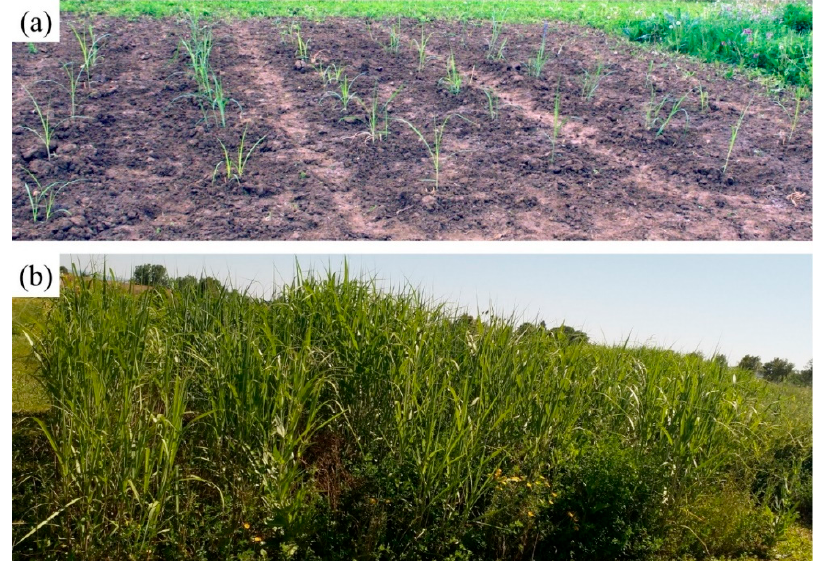
Figure 4. The demonstration plot at field trial near the University of Hohenheim in southwest Germany one day after planting (15 May 2017) ( a ), and during the third vegetation period (29 June 2019) ( b ).